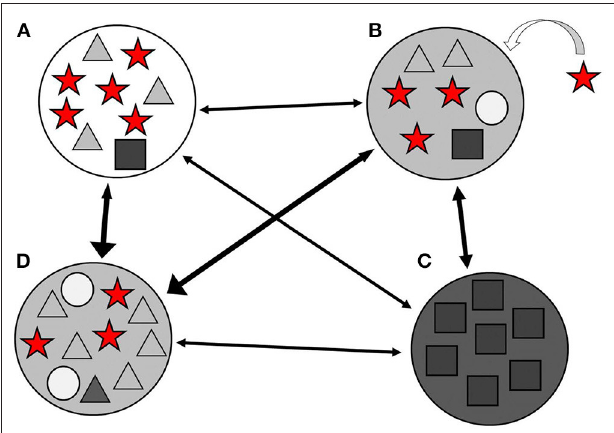
FIGURE 2 | Schematic representation of the mechanisms and limitations of spread of an invasive species through a metacommunity. The invasive species is depicted in red and initially propagates into patch A. Spread to patch B is facilitated by the more permissive local conditions and lack of local filtering. Despite a moderate amount of environmental filtering in patch C, establishment is facilitated by substantial dispersal from A to C. Finally, the invader fails to establish in patch D despite relatively strong dispersal because of impermissive local